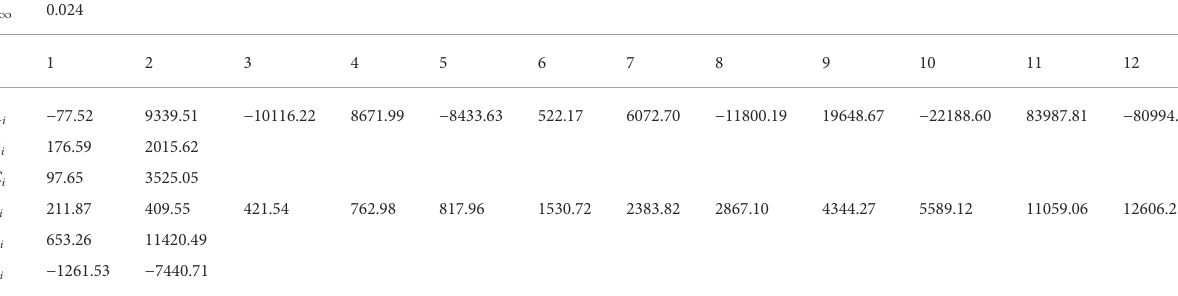
TABLE 2 Parameters y ∞ , A i , B i , C i , λ i , α i , and β i for MPPGW door. The parameters were fi tted at 50 Hz — 2